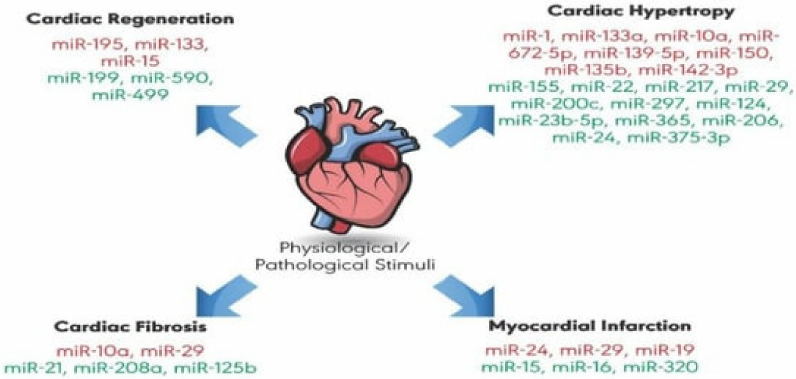
Figure 12. MicroRNAs suggested to play a role in physiological and pathological cardiac remodeling. Some micro RNAs have a protective role (green color) against cardiovascular diseases, whereas others promote extensive cardiac remodeling, leading to disease (red color). Reprinted with permission from [218]. 2019, Int. J. Mol. Sci. is open access journal of